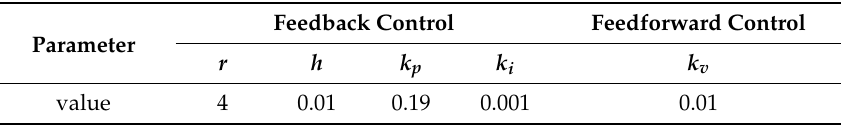
Table 5. Parameters of longitudinal control for